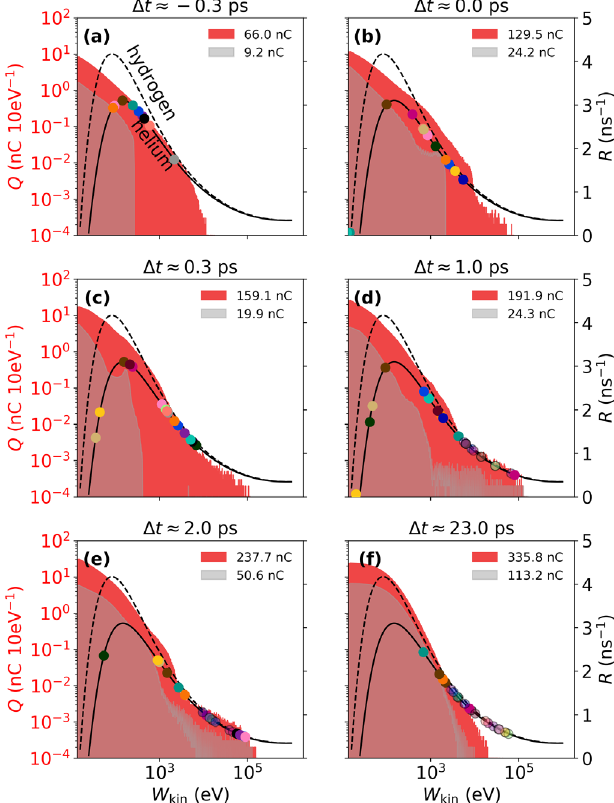
3. Simulated evolution of the spectral plasma